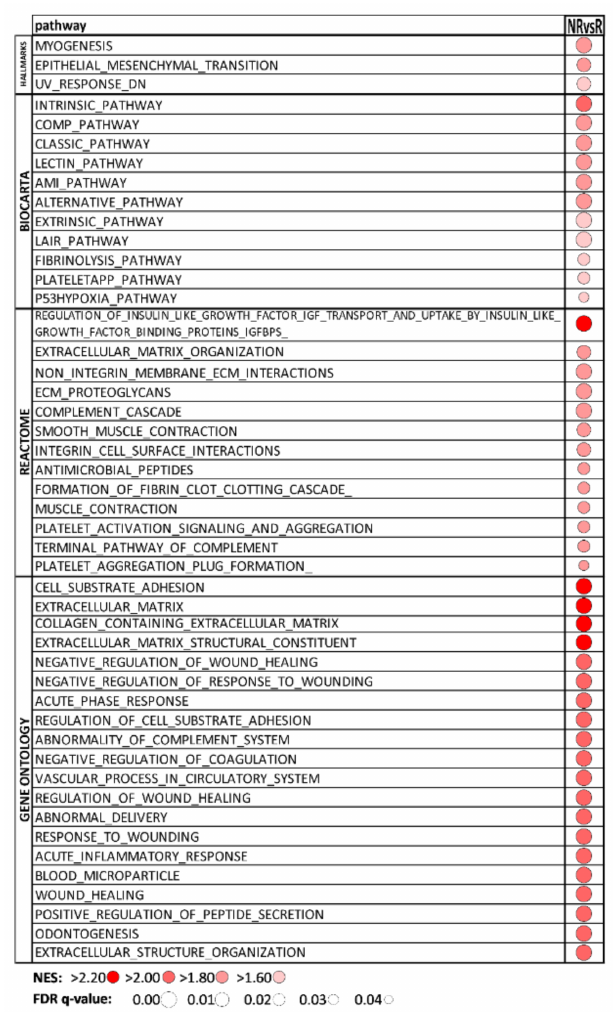
Figure 2. GSEA results: significantly (q < 0.05) positively enriched pathways in NR vs. R comparison. All significant pathways in Hallmark, BIOCARTA and Reactome databases are showed; the top 20 significant pathways are presented in Gene Ontology. NR—non-responders, R—responders, NES—normalized enrichment